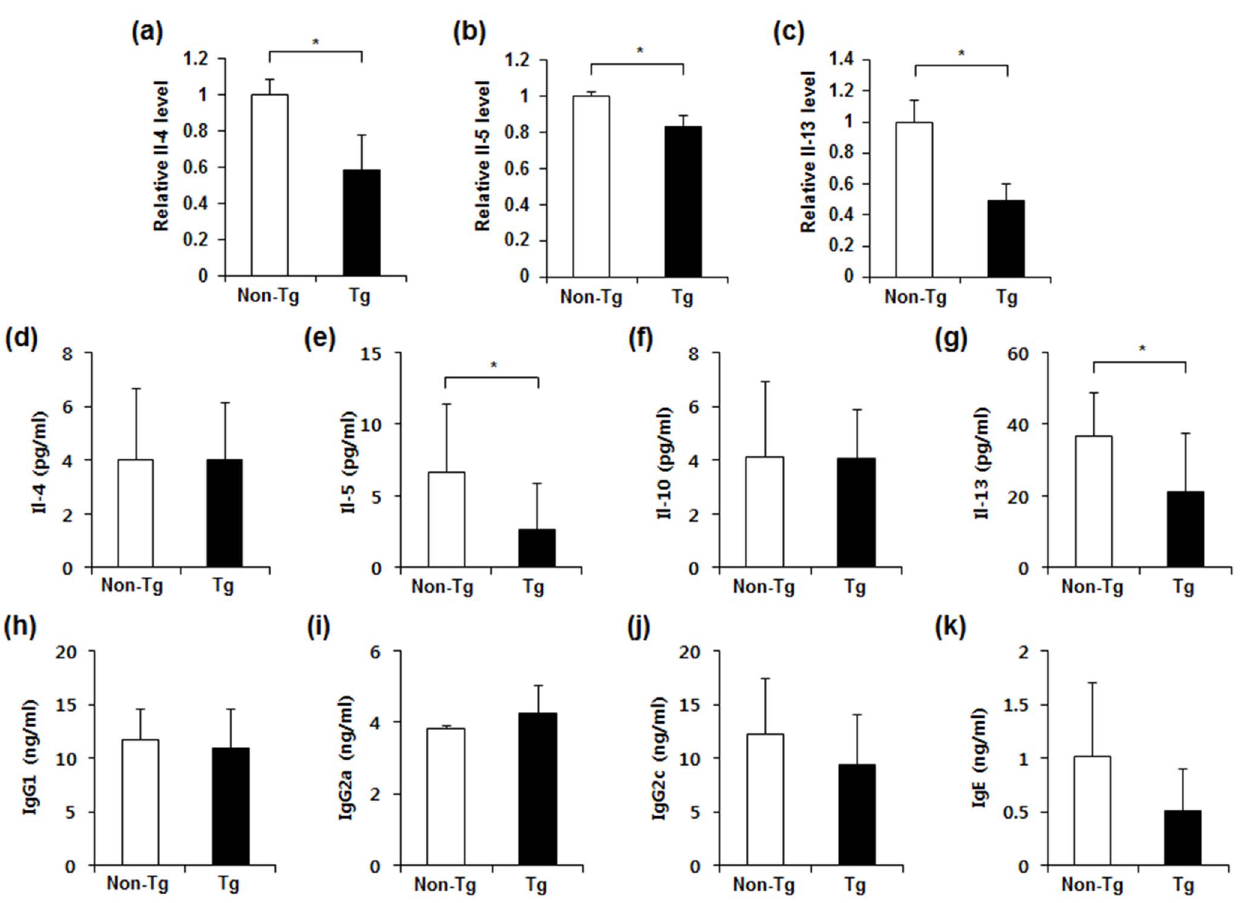
Figure 6. Retnla overexpression decreased the levels of IL-4, IL-5, and IL-13 in OVA-induced asthmatic lung. (a–c) The mRNA levels of IL-4 (a), IL-5 (b), and IL-13 (c) were determined by qPCR analysis of RNA from lungs of OVA-induced Retnla- Tg and non-Tg mice (n 5 7 to 8 per group). (d–k) Levels of IL- 4 (d), IL-5 (e), IL-10 (f), IL-13 (g), IgG1 (h), IgG2a (i), IgG2c (j) and IgE (k) in the BAL fluid were measured by ELISA. Data are presented as mean ¡ SD. Statistical analysis was performed with the Mann-Whitney U -test; * P ,